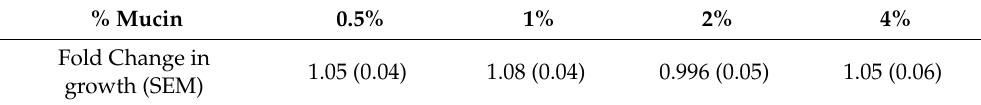
Figure 2. Mucin does not enhance K803 growth. Growth of K803 in increasing mucin concentrations after 3 h graphed as compared with growth of bacteria in LB alone for the same time period. Controls were normalized to 1 and are indicated by the dashed line. Bars are means with 95% CI, n = 3. Table 2. Fold change in E. coli growth in mucin as compared with growth in Luria Bertani broth.